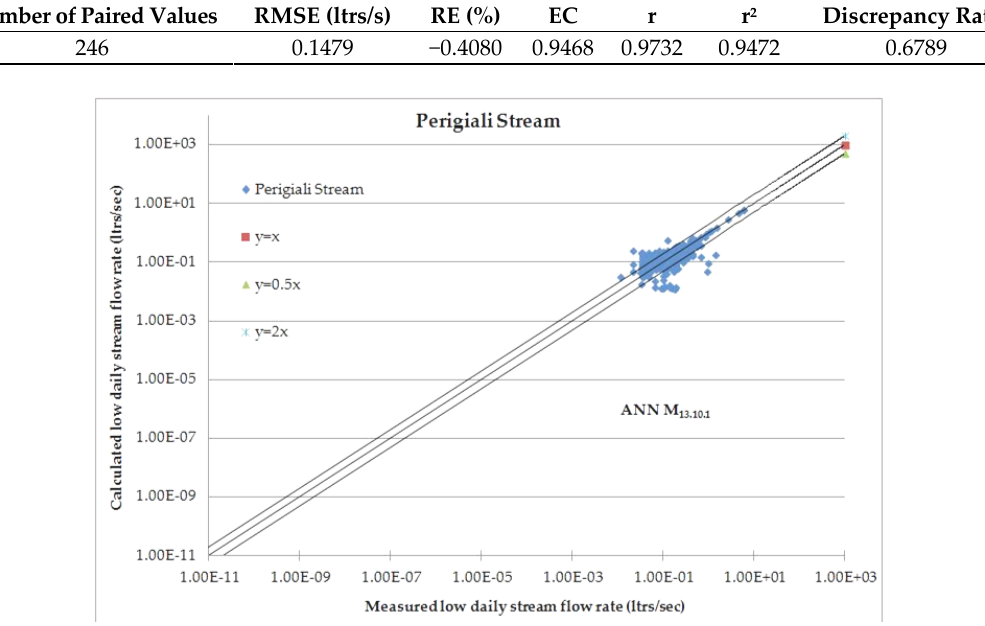
Figure 5. Discrepancy ratio plot of Perigiali Stream (ANN M 13.10.1